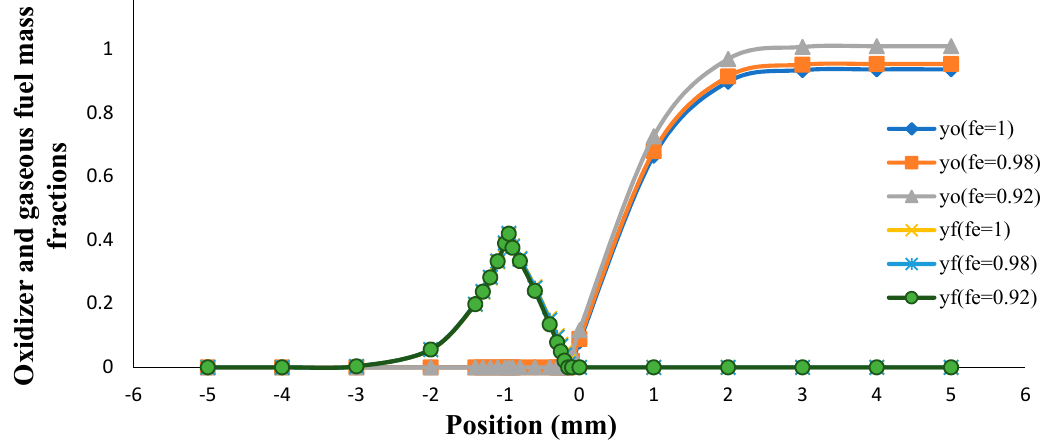
Figure 12. Oxidizer and gaseous fuel mass fractions against the position for different mass particle concentrations.